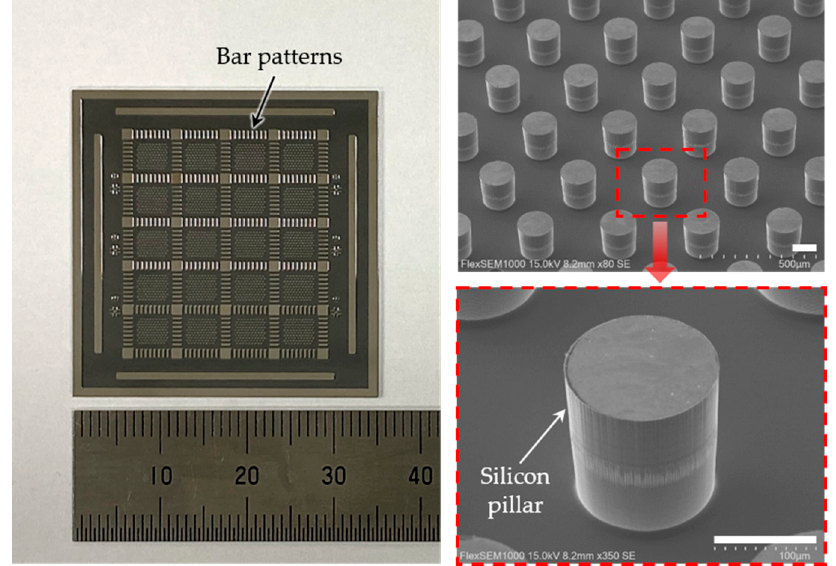
Figure 3. (Left) Photograph of a chip containing 20 arrays of circular silicon pillars, in a dimension of 35 mm × 35 mm. (Right) Scanning electron microscopic (SEM) images of silicon pillars after deep reactive ion etching. The scale bars are 100 μ m.